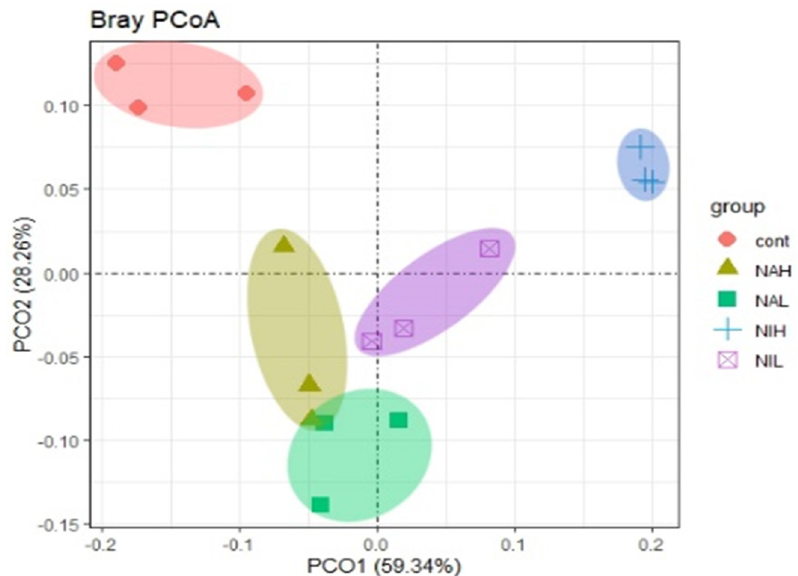
Figure 4. Principle coordinate analysis (PCoA) of community structure based on the Bray–Curtis distance from the different treatments. Cont: control; NAH: 1 mg/L sodium selenate); NAL: 100 µg/L sodium selenate; NIH: 1 mg/L sodium selenite; NIL: 100 µg/L sodium selenite.